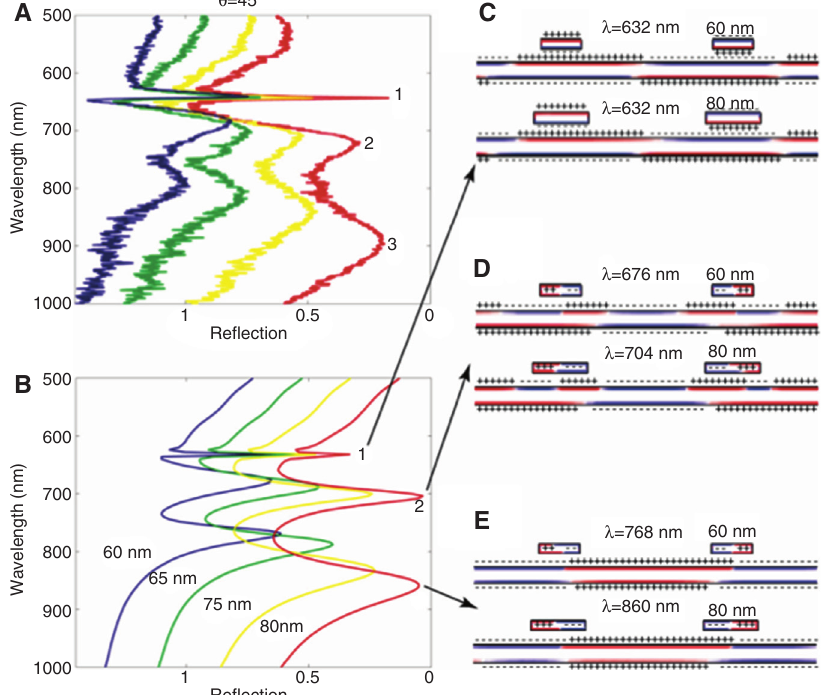
Figure 13: (A) Measured and (B) simulated reflection spectra at θ 1/4 45 deg incidence for gratings of widths w 1/4 80, 75, 65, and 60 nm. Each curve is displaced by an amount of 0.2 from the previous one for viewing purposes. (C) Surface charges for band 1 showing an odd surface plasmon-polariton (PSP) resonance. (D) Surface charges for band 2 showing a parallel hybridization combination of the even/ compound PSP and the localized dipole+mirror image resonance. (E) Surface charges for band 3 showing the antiparallel hybridization combination. Reprinted figure with permission from A. Farhang, T. Siegfried, Y. Ekinci, H. Sigg, and O. J. F. Martin, “Large-scale sub-100 nm compound plasmonic grating arrays to control the interaction between localized and propagating plasmons,” J. Nanophotonics, vol. 8, p. 083897, 2014. Copyright 2014 by